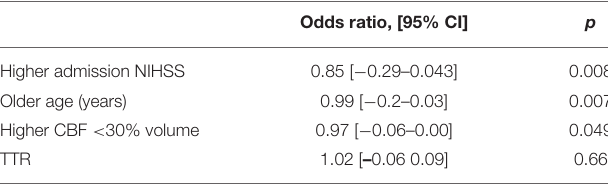
TABLE 3 | Odd Ratios of the variables assessed in the prediction